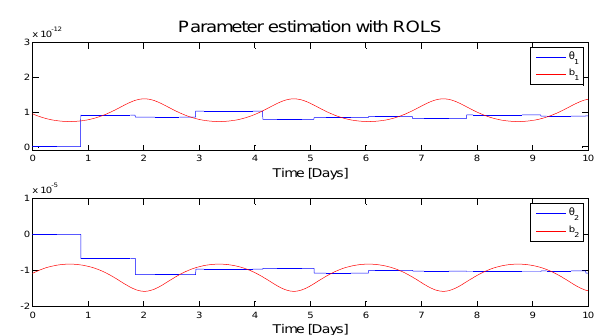
Figure 8: Simulating the values of the estimated pa- rameters, calculated in the ROLS model, us- ing the earlier presented synthetic data set. The ”‘rapid”’ oscillation of the parameters is not detected by the ROLS-model. The esti- mated parameters are close to the mean value of the parameters, and will only follow long term variations of the